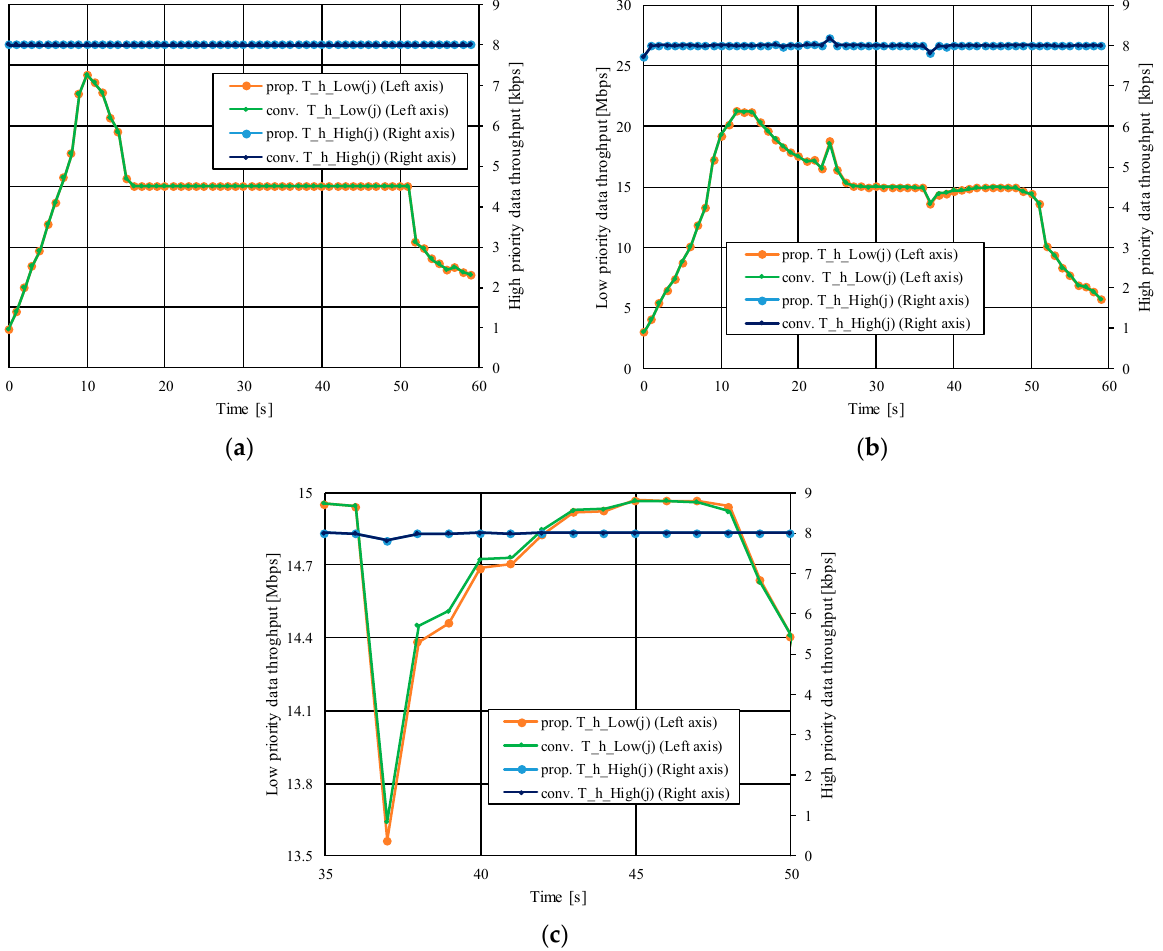
Figure 12. Throughput characteristics; ( a ) Scenario A. ( b ) Scenario B, ( c ) enlarged view of Scenario B.